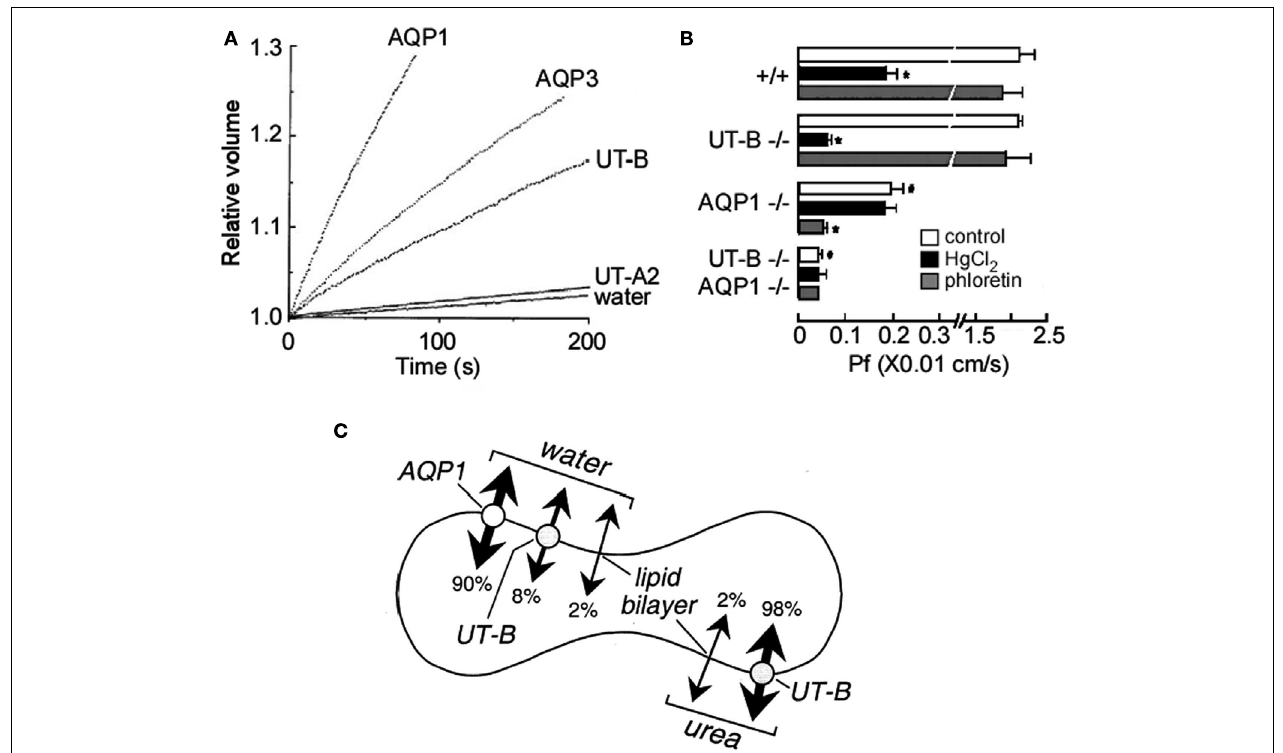
250-mM inwardly directed sucrose gradient.These data were obtained in erythrocytes from mice of indicated genotype at 10˚C, under control conditions and in the presence of 0.3mM HgCl 2 or 0.7mM phloretin.Values are expressed as means ± SE, n = 3 mice/genotype. * p < 0.01 compared with no inhibitor. # p < 0.01 compared withWT in control conditions P f . (C) Relative contributions of AQP1, UT-B, and the lipid bilayer to erythrocyte water and urea permeability at 10˚C. Reproduced fromYang andVerkman (1998, 2002).